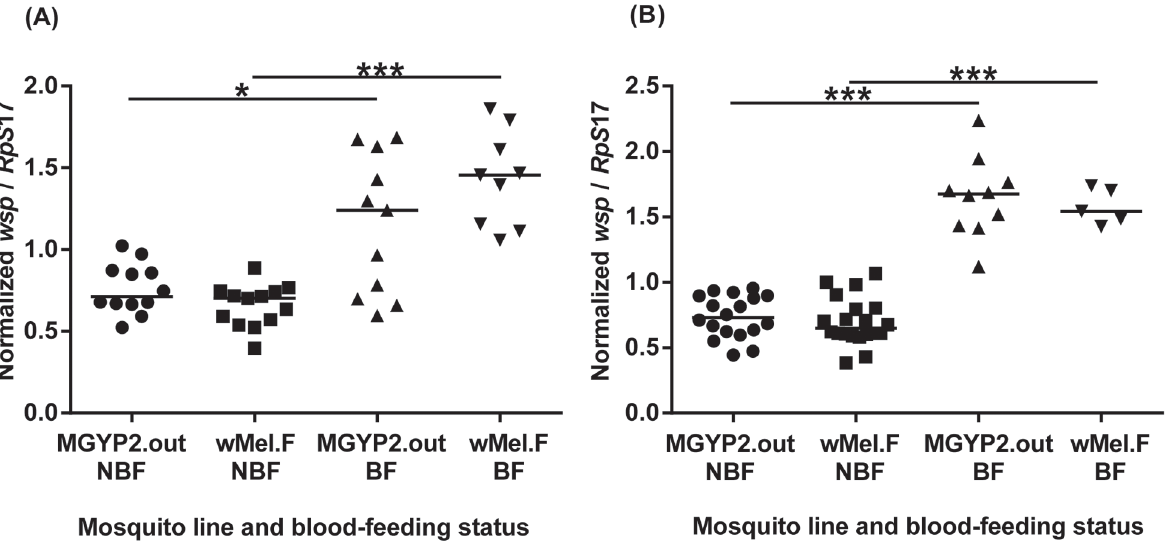
Figure 4. Blood-feeding and Wolbachia densities in whole mosquitoes. Outbred laboratory w Mel (MGYP2.out) and field-released w Mel ( w Mel.F) A. aegypti at 7 (A) and 14 (B) days post blood-feeding (BF) versus non-blood fed (NBF) controls. Bars denote medians. P , 0.05 (*), P , 0.01 (**), P , 0.001 (***). Each point represents an individual mosquito.